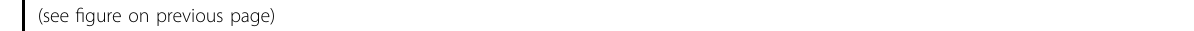
Fig. 1 Characterization of the RBD – ACE2 – SIT1 complex. a Representative SEC puri fi cation of the SIT1 – ACE2 – BA.2 RBD. SDS-PAGE was visualized by Coomassie blue staining. b Overall structure of the SIT1 – ACE2 – BA.2 RBD (left) complex and SIT1 – ACE2 – BA.5 RBD complex (right). The complexes are colored by subunits. Promoters are shown in different colors. c Interface of ACE2 and BA.2 RBD. d The detailed analysis of the interface between Omicron variants and ACE2. RBD of BA.2, BA.5, and WT are colored blue, green, and orange, respectively. The PDB ID for the WT structure is 6M17. e Structure of the transmembrane domain of ACE2 and SIT1 is shown in the middle. ACE2 and SIT1 are colored purple and light salmon, respectively. Insets: enlarged views of the interface between the transmembrane helix of ACE2 and transmembrane helix 3, 4, 9 of SIT1 (left) and the interface between the extracellular loop of ACE2 and TM7 of SIT1 (right). f Diagram of the fl ow cytometry-based RBD binding assay. See Methods for detail. g , h RBD binding curves of HEK293-ACE2 cells overexpressing GFP (black) or SIT1(blue) for WT ( g ) and BA.5 RBD ( h ). For WT RBD, EC 50 values for cells overexpressing GFP and SIT1 are 43.64nM and 63.23 nM, respectively. For BA.5 RBD, EC 50 values for cells overexpressing GFP and SIT1 are 16.99 nM and 18.41 nM, respectively. Data are shown as means ± SD ( n = 3). i Cell-surface ACE2 levels of cells overexpressing ACE2 and/or SIT1 measured by fl ow cytometry. Data are shown as means ± SD ( n = 3). j Representative confocal images for ACE2 and SIT1 localization in cells overexpressing ACE2 and/or SIT1. White arrows indicate the colocalization of ACE2 and SIT1 in the cytosol. Scale bar, 10